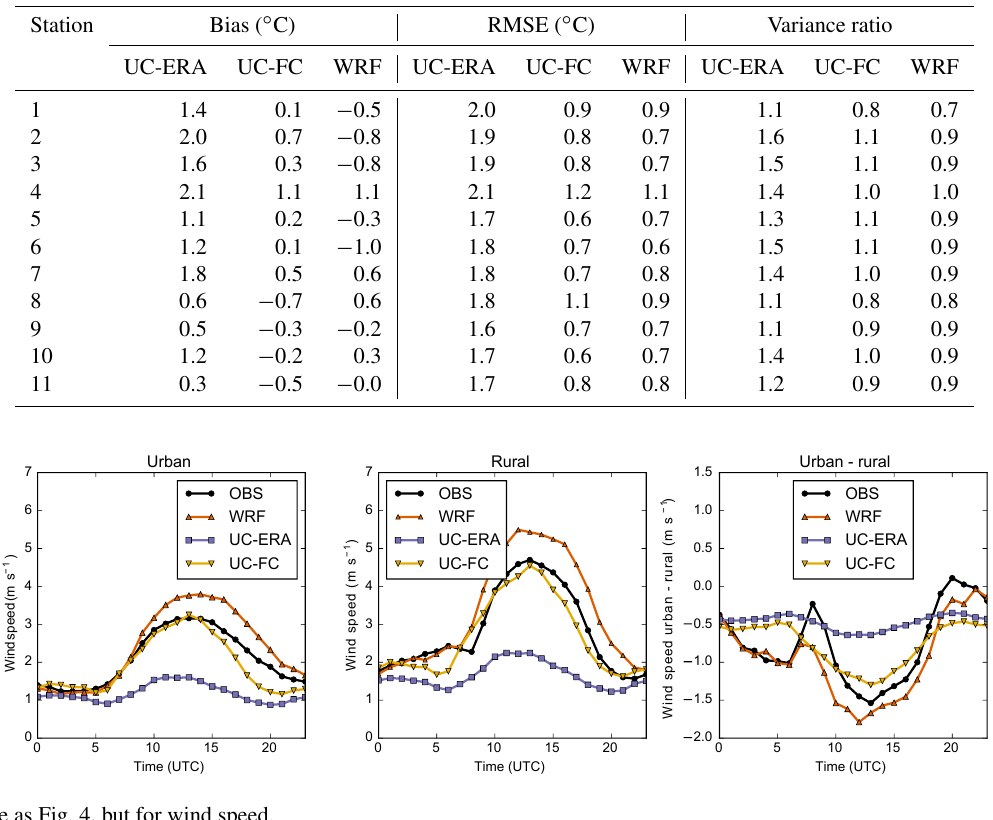
Figure 5. Same as Fig. 4, but for wind